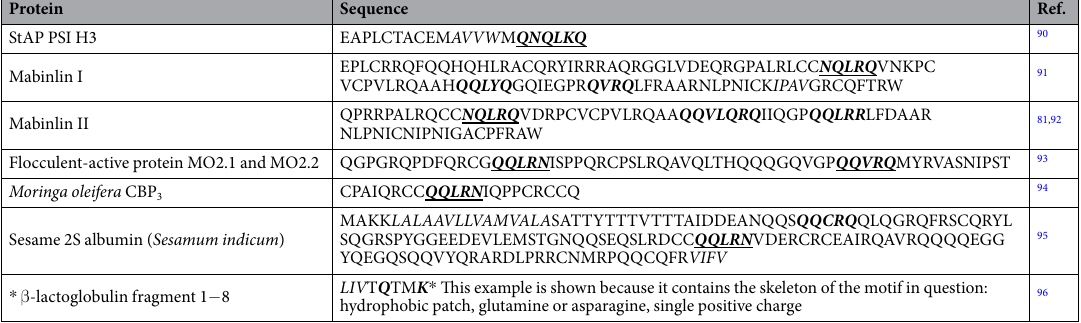
Table 1. Examples of antimicrobial/membrane-interacting proteins that contain the [N/Q]-[N/Q]-[A/L/ I/V]-[R/K]-[N/Q] sequence motif (bold underlined italic). Sequences similar to the motif (bold italic) and hydrophobic patches (italic) are also